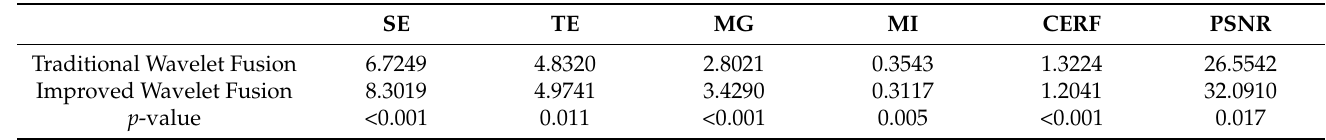
Table 2. Objective evaluation results of fusion algorithm.